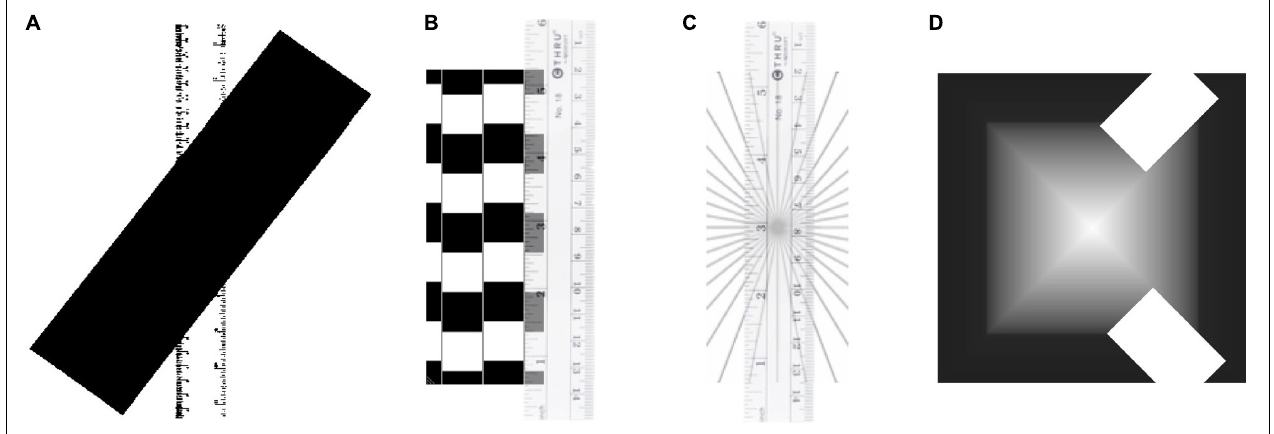
FIGURE 1 | (A) Poggendorf illusion with a ruler as the test figure (from Blakemore, 1973). (B) Café Wall illusion (Gregory and Heard, 1979) with a ruler overlaid on one of the apparently slanted lines, verifying its physical straightness. (C) Hering curved line illusion with the same ruler as its test figure. (D) Pyramid illusion (Vasarely, 1966), a variation of the Mach Band illusion. The white rectangles depict how two business cards could be overlaid to verify that the luminance is uniform across the width of each triangular face of the